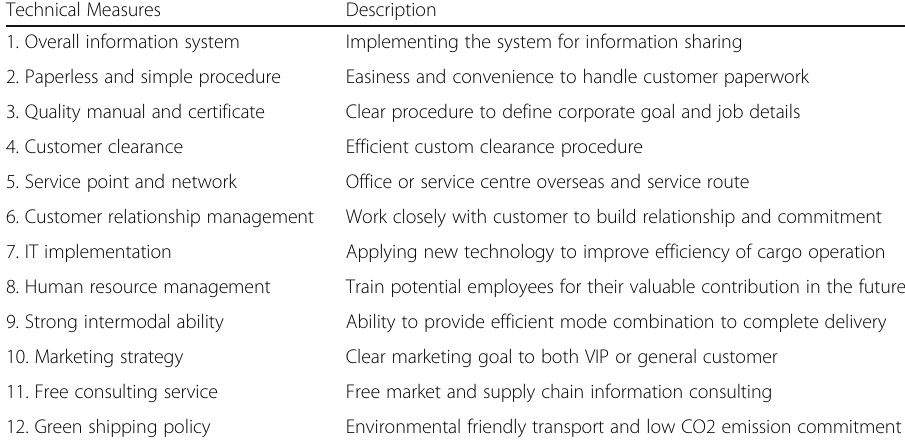
Table 2 Technical measures in the empirical work